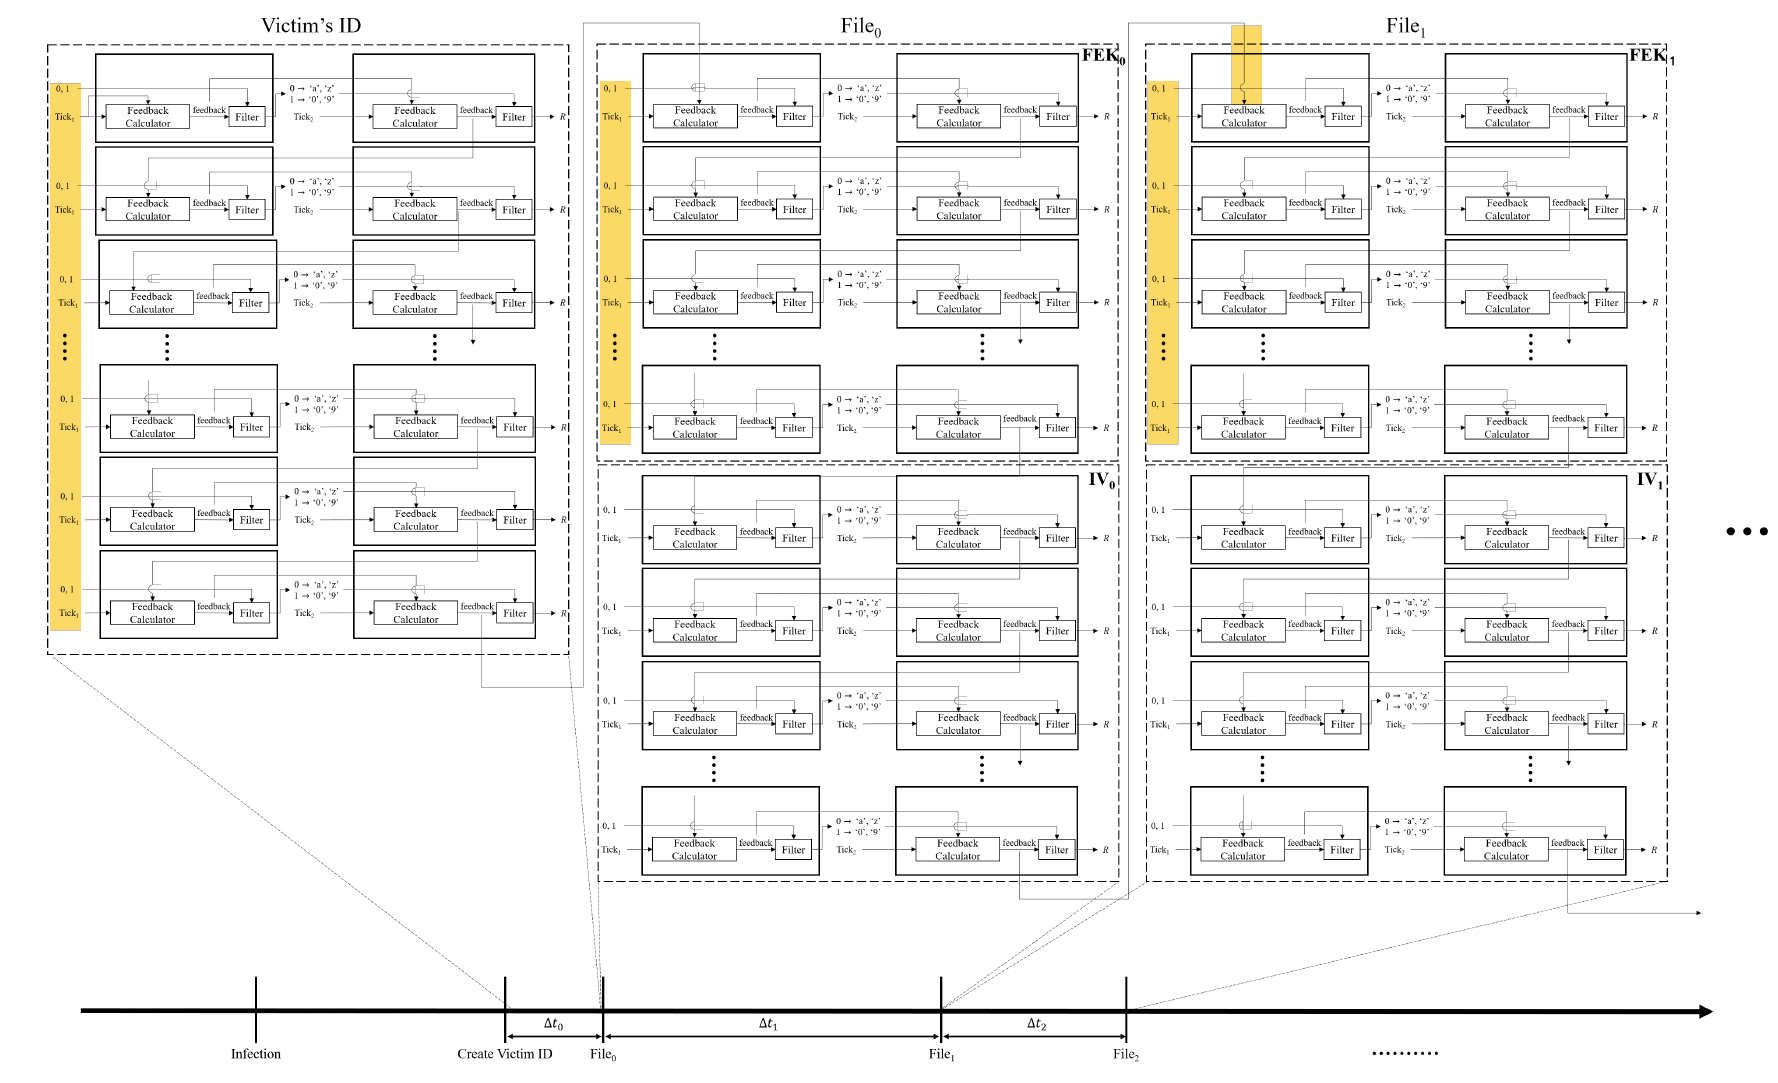
Figure 5. Entire process of MPRNG during